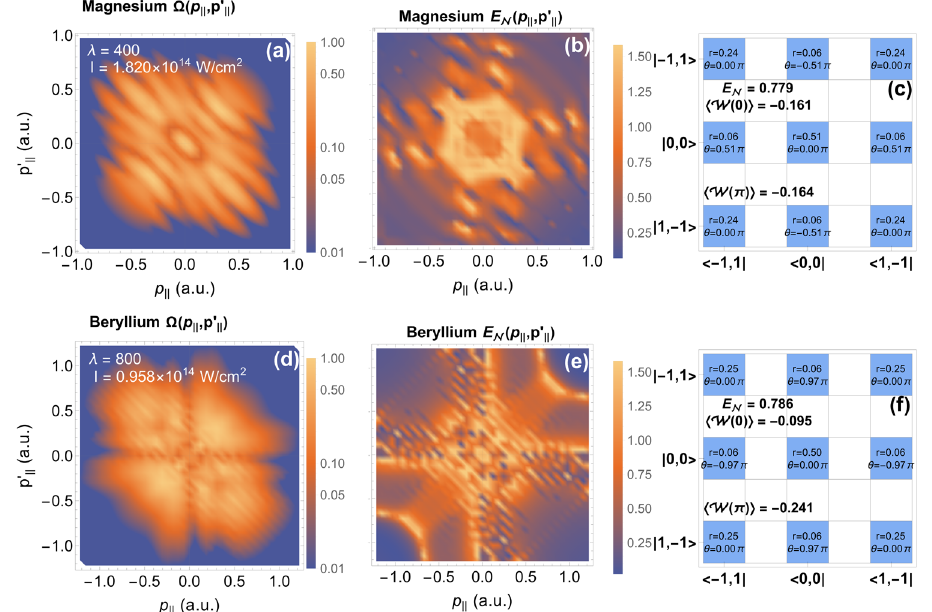
Fig.3|Momentumdependentprobability,logarithmicnegativity,anddensity matrices.a and d Thecorrelatedmomentumdistribution Ω ð p ∣∣ , p 0 ∣∣ Þ formagnesium and beryllium, respectively, with respectto the parallel momentum coordinates p ∣∣ and p 0 ∣∣ . We have integrated over the components perpendicular to the laser fi eld polarization, given by (14). A logarithmic scale is given, normalized to the peak valueinarbitraryunits.Thetargetisgiveninthetitle,whilethe fi eldparametersare listed in the top left. b and e Momentum-dependent logarithmic negativity